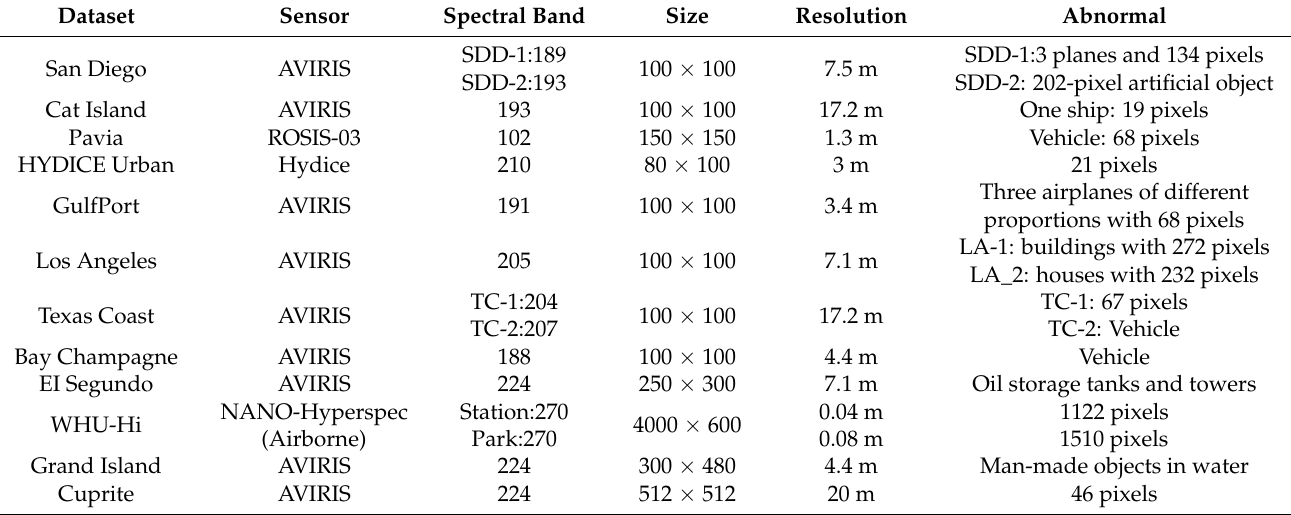
Table 1. Summary of airborne data sets commonly used for hyperspectral anomaly